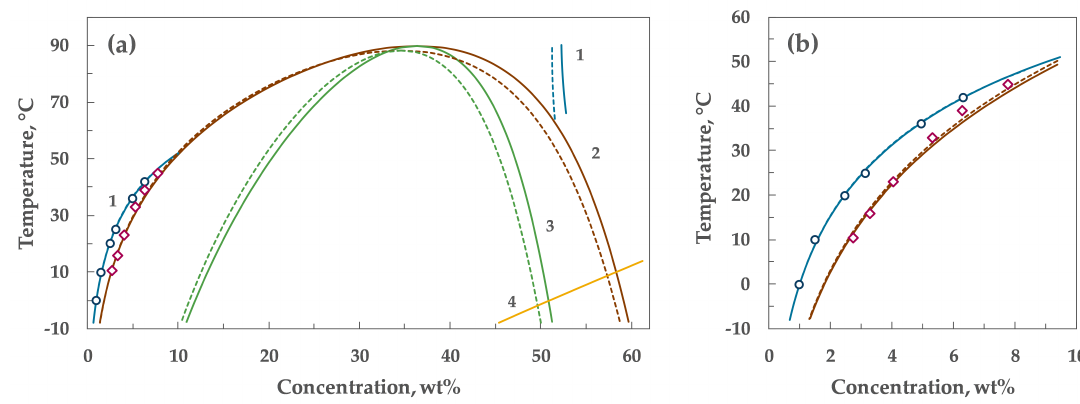
Figure 3. Experimental data and model predictions for the idebenone – hexane / methylene chloride (7:1 by volume) system showing ( a ) the complete phase diagram, and ( b ) magnified view of the experimental data region. The open circles and diamonds indicate the experimental data points for solubility and oiling out (binodal), respectively, adapted from [5]. Curve 1 represents the model ( µ l = µ s ) fit to solubility data using Equations (16) and (17). The square-well interaction parameters (listed in Table 3) obtained from this fit were used to further calculate the binodal (curve 2), spinodal (curve 3), and gelation (curve 4) boundaries. The dotted lines are the curves obtained using Equation (11) and the solid lines are those obtained with Equation (12), respectively, for calculating η e ff . The dotted and solid lines for curve 4 are almost